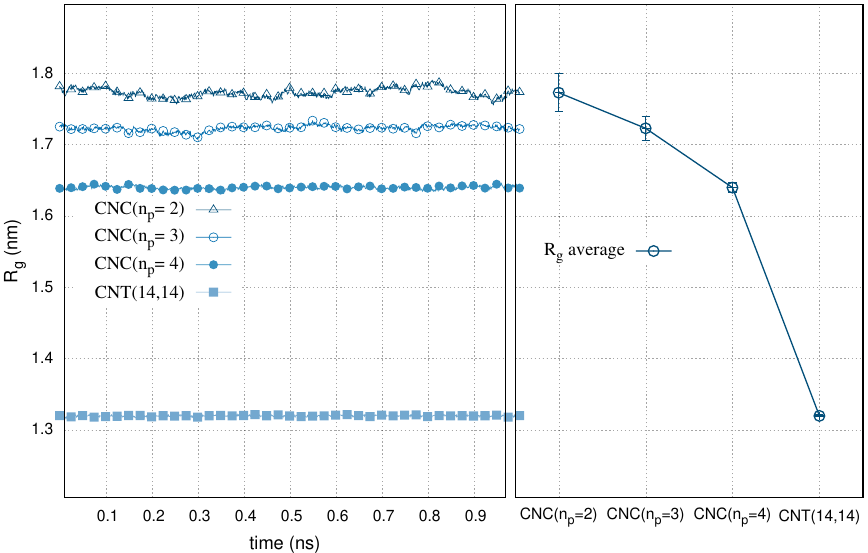
Figure 1. Radius of gyration, R g , for the water embedded CNT(14,14) and nanocones (CNCs) with different number of pentagons, n p , at the tip, as a function of time. Right panel: The averaged values are shown with y-axis error bars. The error bars are multiplied by 5.0 to guide the